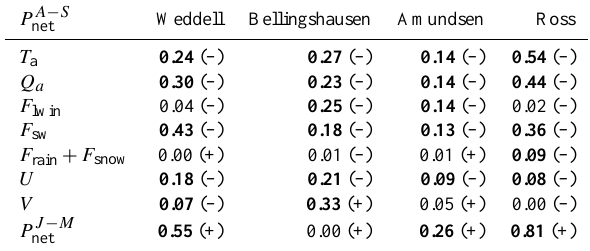
Table 3. Spatial linear regression of the temporal mean (1985–2011) autumn/winter (April–September) net surface power input to the mixed layer against the temporal mean (1985–2011) autumn/winter: 2m air temperature, 2m specific humidity, incom- ing long-wave radiation, incoming short-wave radiation, total pre- cipitation (rain and snow), 10m zonal (positive eastwards) wind speed, 10m meridional (positive northwards) wind speed, and sum- mer (January–March) net surface power input, for each of the re- gions shown in Fig. 11. Each regressed data point corresponds to a specific grid cell and represents the grid point temporal mean value. The coefficient of determination ( r 2 ) is shown in the table, where significant ( > 99%) correlations are highlighted in bold. The sign in parentheses indicates the sign of the respective r value. Note that F rain + F snow = P as in Fig.